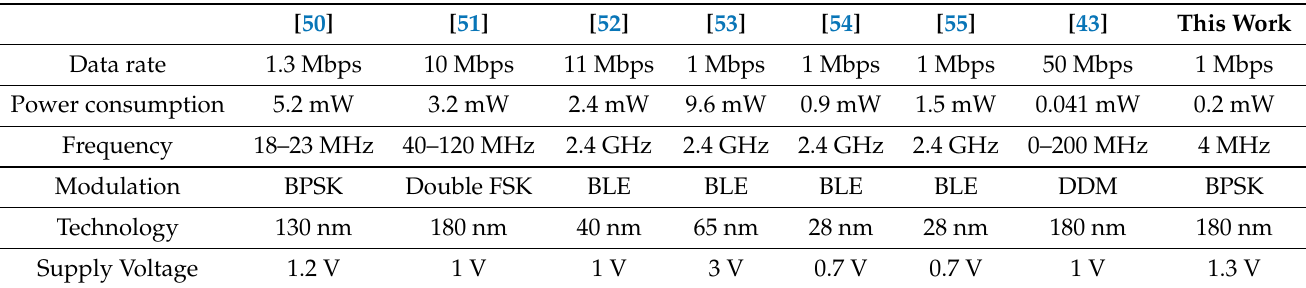
Table 4. Comparison with recently published IC-receivers. (DDM—Differential detection method, BLE- Bluetooth Low Energy).